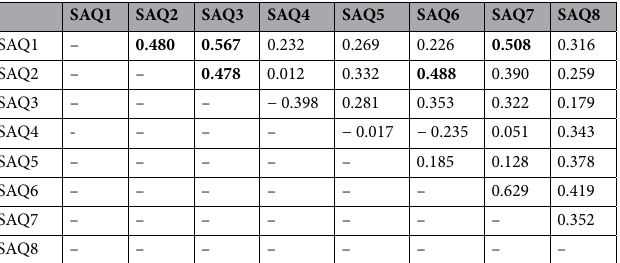
Table 4. Correlation between the answers to the user self-assessment questions (SAQ). *Statistically significant correlations (p < 0.05) are denoted in